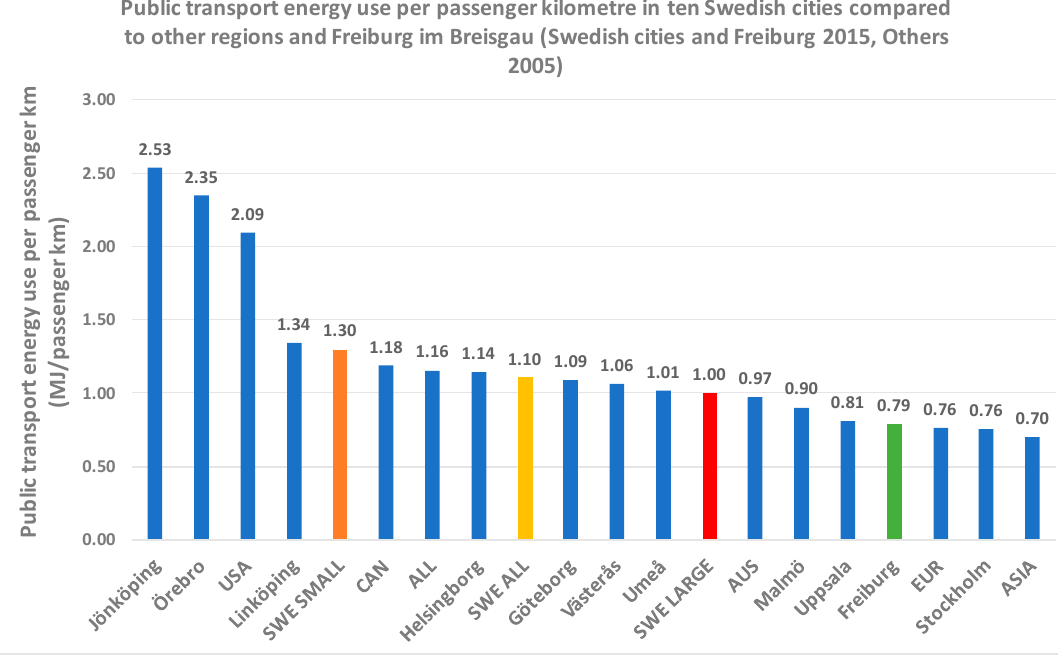
Figure 5. Energy use per PKT in public transport in ten Swedish cities (2015); Freiburg (2015); and American, Australian, Canadian, European and Asian cities (2005–2006).